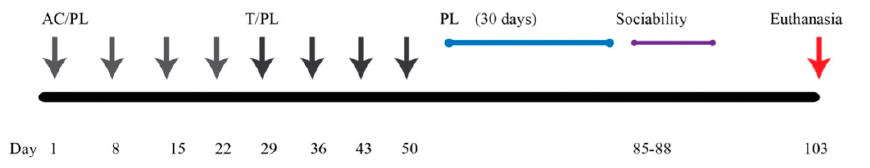
Figure 9. Graphical representation of experimental design and timeline.